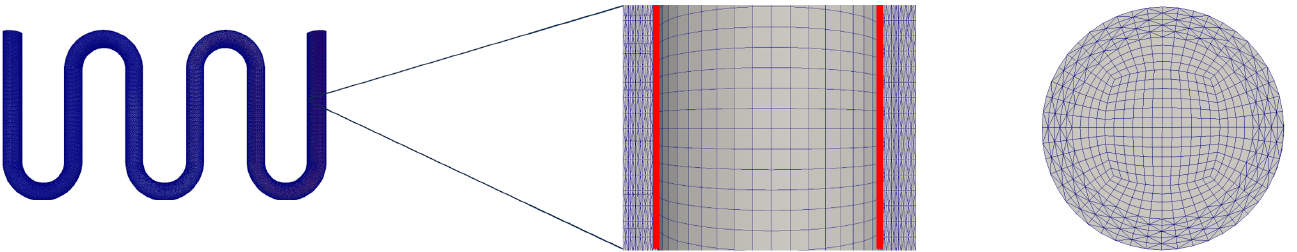
Figure 4. Representation of the mesh. ( Left ): highlight of the coupling surface. ( Right ): cross- sectional view of fluid and solid